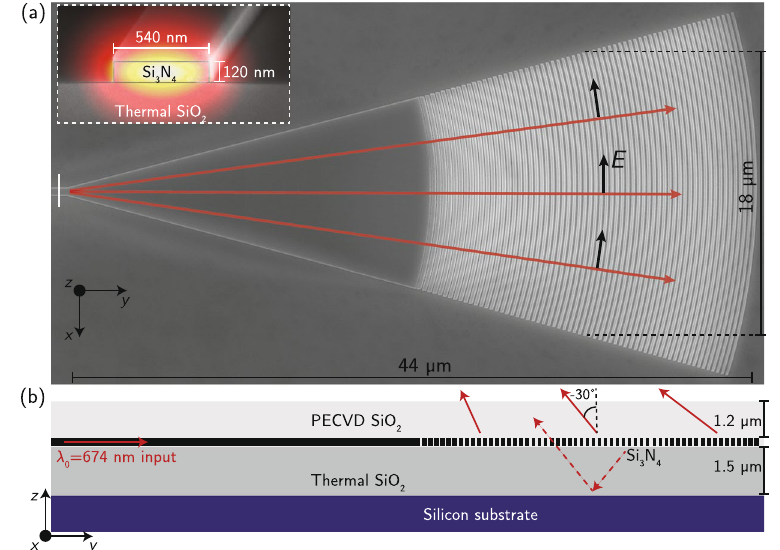
Figure 1. Device overview. ( a ) Cross section. ( b ) Simulated field profile of the quasi-TE mode (field points predominantly horizontally, i.e. along x ) of the SM waveguide feeding the taper, and ( c ) SEM of fabricated